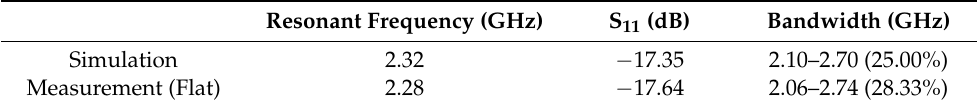
Table 2. Simulated and measured performance comparison of the antenna under the flat state.